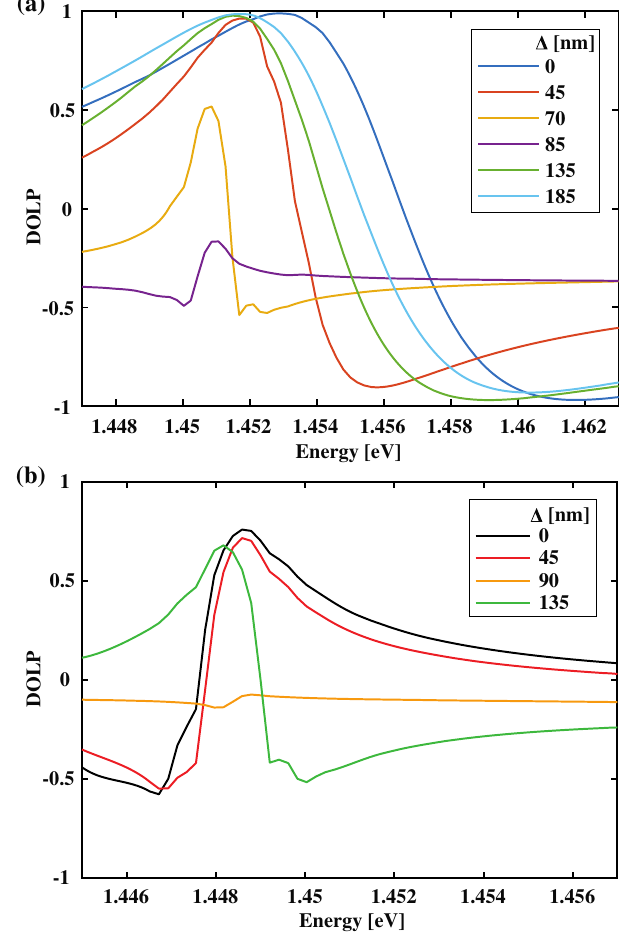
FIG. 15. 3D FEM modeled DOLP as a function of the dipole emission energy and position Δ . DOLP was calculated using the x - and y -polarized intensities I and I of the x - and y -oriented x y dipoles d and d shown in Fig. 14. x y